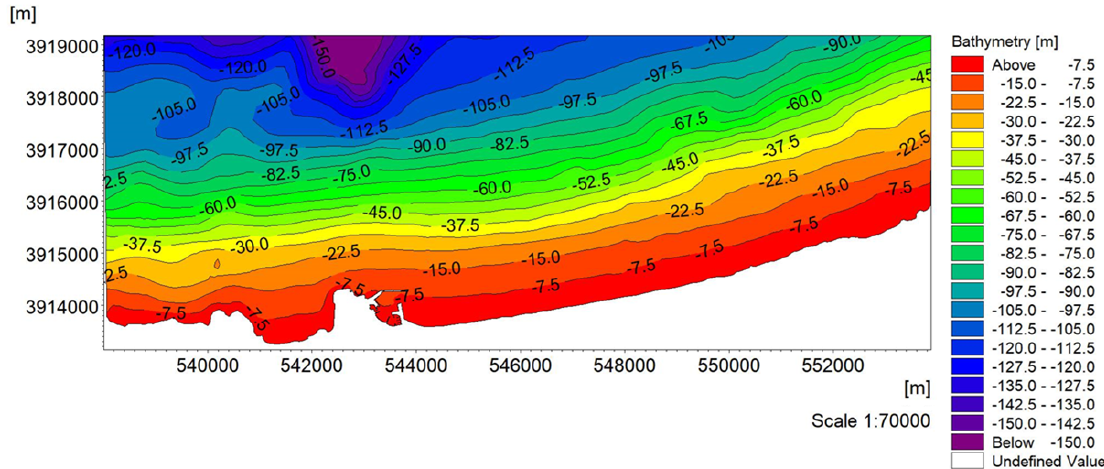
Figure 3. Contour map of the bathymetry in the area of study in the vicinity of port of Rethymno.